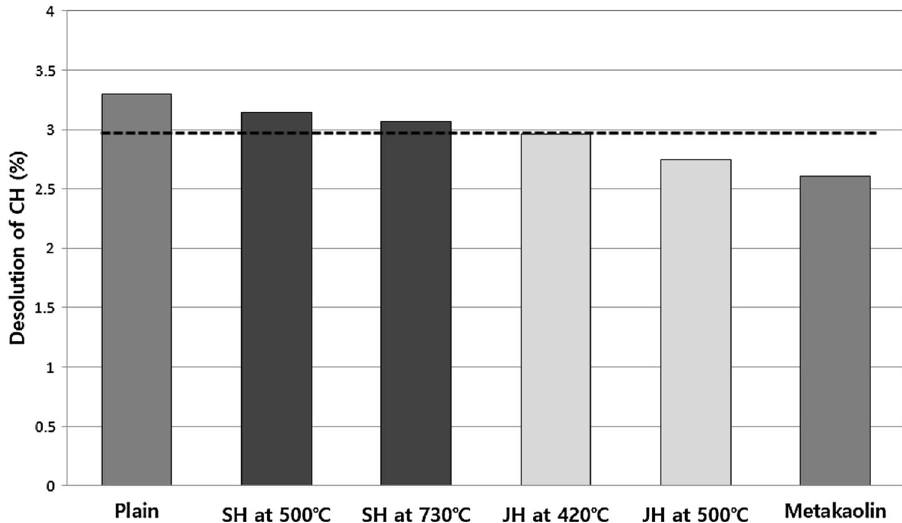
Fig. 9 The amount of weight loss in w/b 0.5 cement paste at about 450 (cid:2) C (the dashed line indicates 90% of the weight loss in the plain cement paste, which considered the 10% replacement of dredged sea soil and metakaolin with the